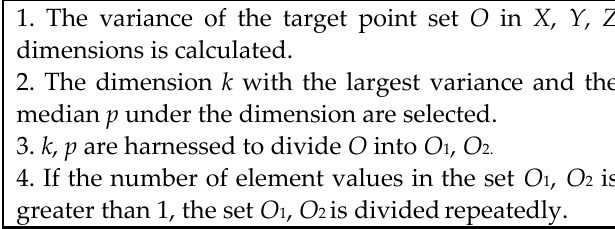
Figure 6. The k-d tree stores cloud data.